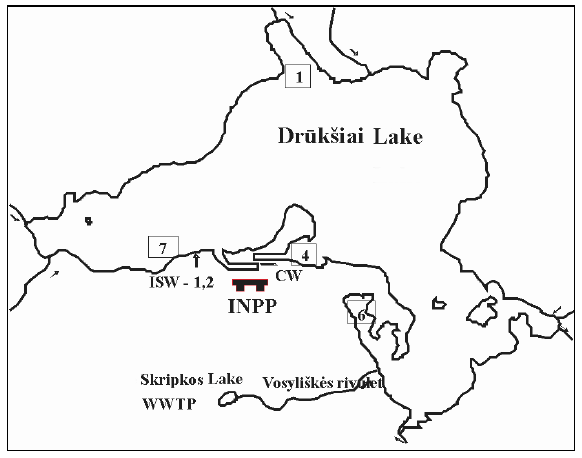
Fig. 1. Scheme of the discharge channels of the Ignalina NPP and monitoring stations of Drūkšiai Lake Toxicity and genotoxicity tests of the water